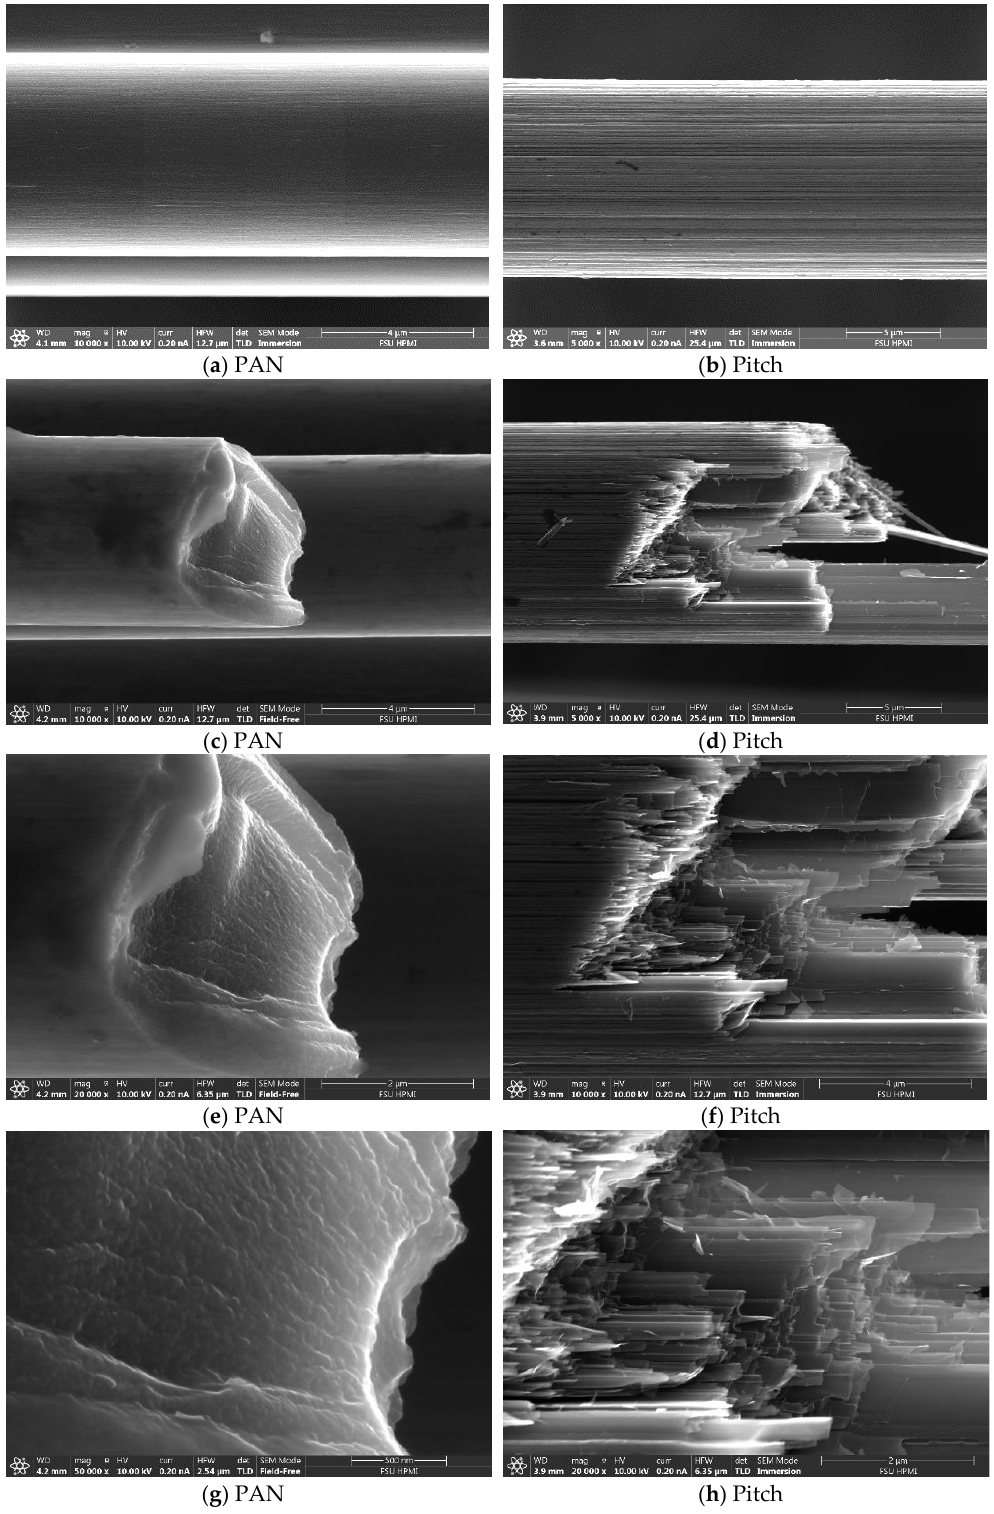
Figure 1. Scanning electron microscopy (SEM) of polyacrylonitrile (PAN) and pitch-based fibers in the ( a , b ) pristine forms and ( c – h ) fractured tensile forms.